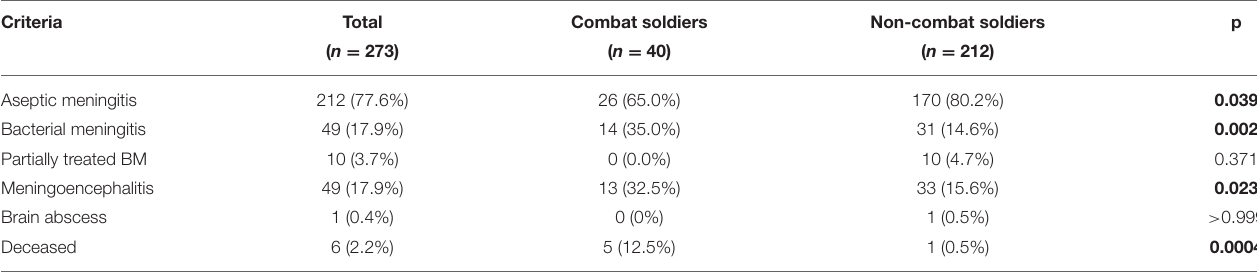
TABLE 3 | Characteristics of combat vs. non-combat soldiers.